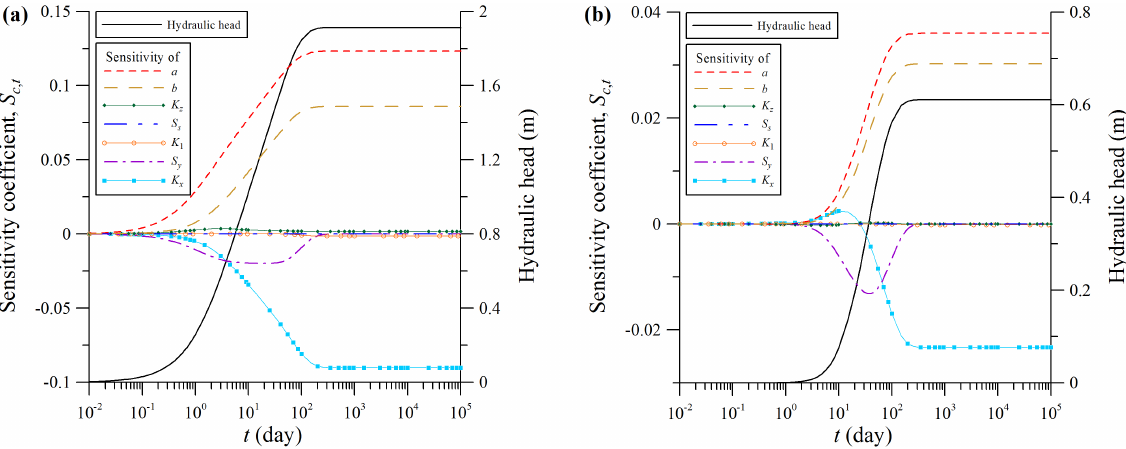
Figure 6. Temporal distributions of the normalized sensitivity coefficients of the hydraulic head at the observation points of (a) ( x , y , z ) = (555, 500, − 10) and (b) ( x , y , z ) = (800, 500, − 10) to the changes in parameters a , b , K z , S s , K 1 , S y , and K x